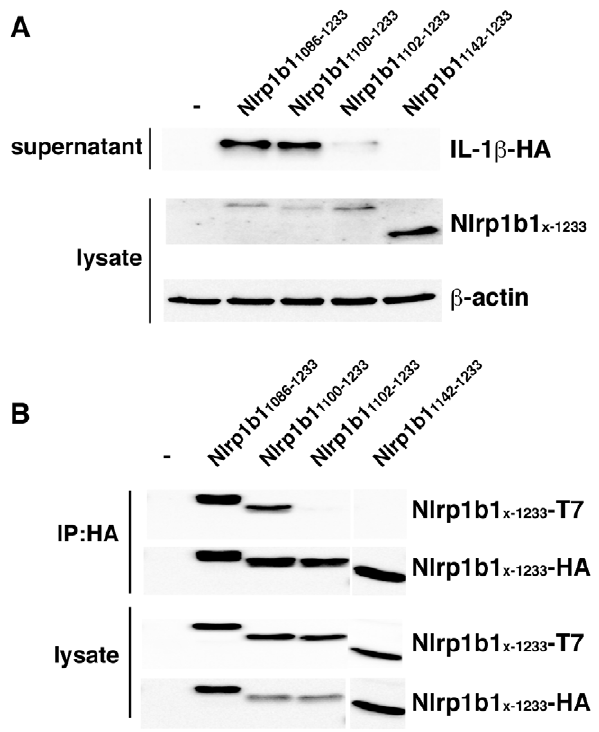
Figure 2. Nlrp1b1 1100–1233 self-associates and actives pro- caspase-1. (A) HT1080 cells were co-transfected with Nlrp1b1 truncation constructs, pcDNA3-pro-caspase-1-FLAG and pcDNA3-pro- IL-1 b -HA as indicated. After 24 h, cells were lysed and lysates were probed for T7-tagged Nlrp1b truncation mutants and b -actin by immunoblotting; supernatants were immunoprecipitated with anti-HA antibodies and then probed for HA-tagged IL-1 b . (B) HT1080 cells were transfected with pcDNA3-His 6 -Nlrp1b1-HA and pcDNA3-His 6 -Nlrp1b1- T7 tagged Nlrp1b1 truncation constructs as indicated. Cells were lysed 24 h after transfection, and proteins were immunoprecipitated using anti-HA antibody, followed by immunoblotting with anti-T7 antibody and anti-HA antibody. Blots are representative of three independent experiments.